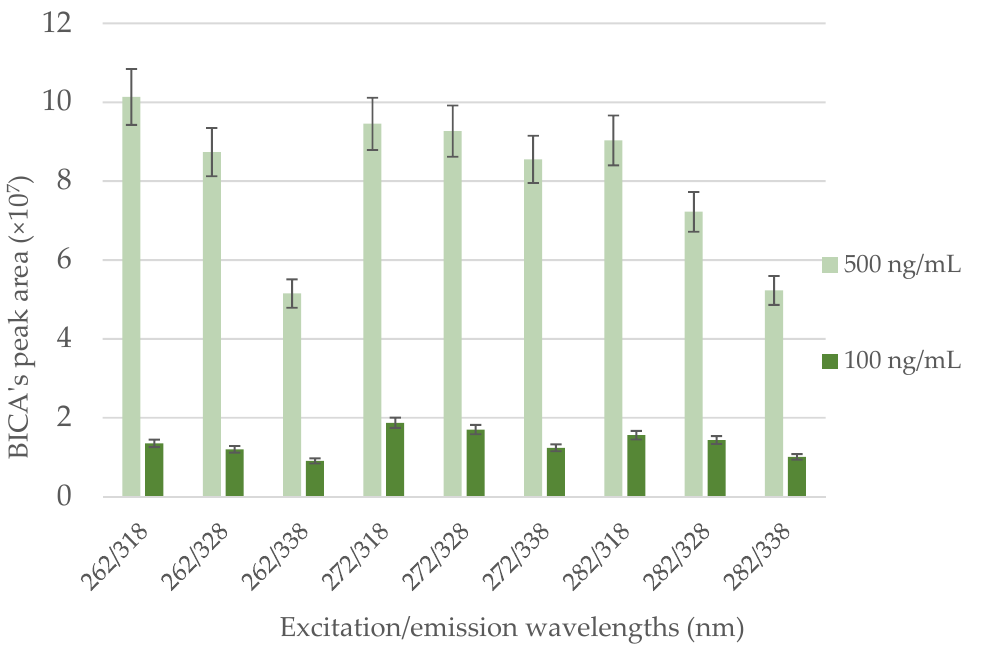
Figure 1. Peak areas obtained for two BICA standards in ultrapure water (100 and 500 ng/mL) by HPLC-FLD at the different combinations of excitation/emission wavelengths (nm).